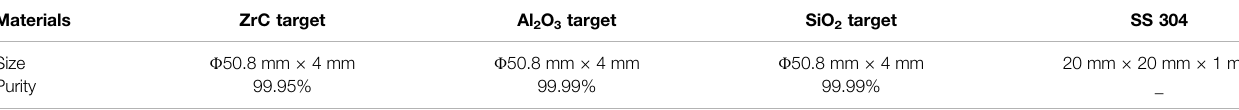
TABLE 1 | The basic information about the used targets and substrate in the QOM-based absorber (CAA). Materials